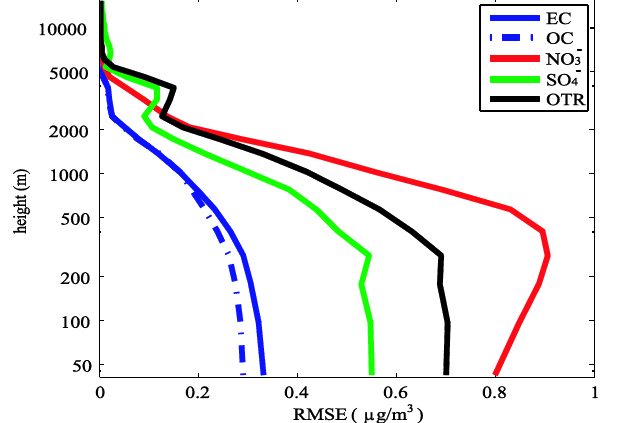
Fig. 2. Vertical distribution of the root-mean-square of the back- Figure 2. Vertical distribution of the root-mean-square of the background errors in ground errors in mass concentration for five species, estimated us- ing the differences between 24 and 48h forecasts valid at the same time. mass concentration for five species, estimated using the differences between 24 and 48 h forecasts valid at the same time.